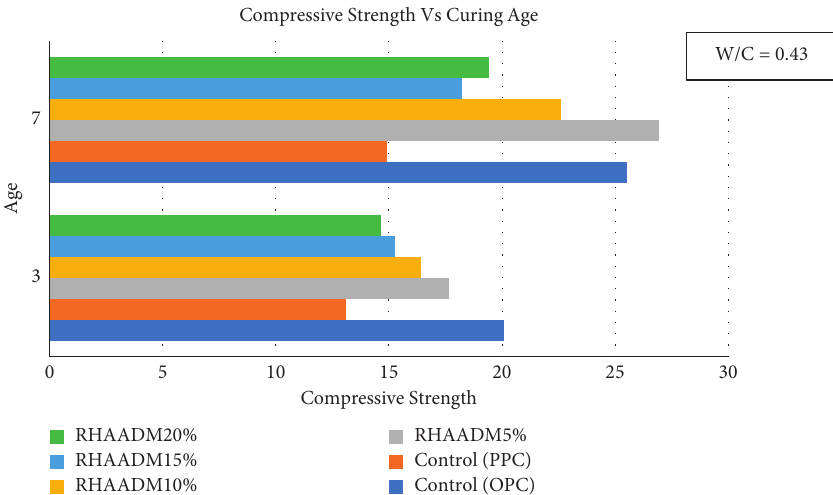
Figure 5: Early compressive strength gain at 3 rd and 7 th curing days with superplasticizer.